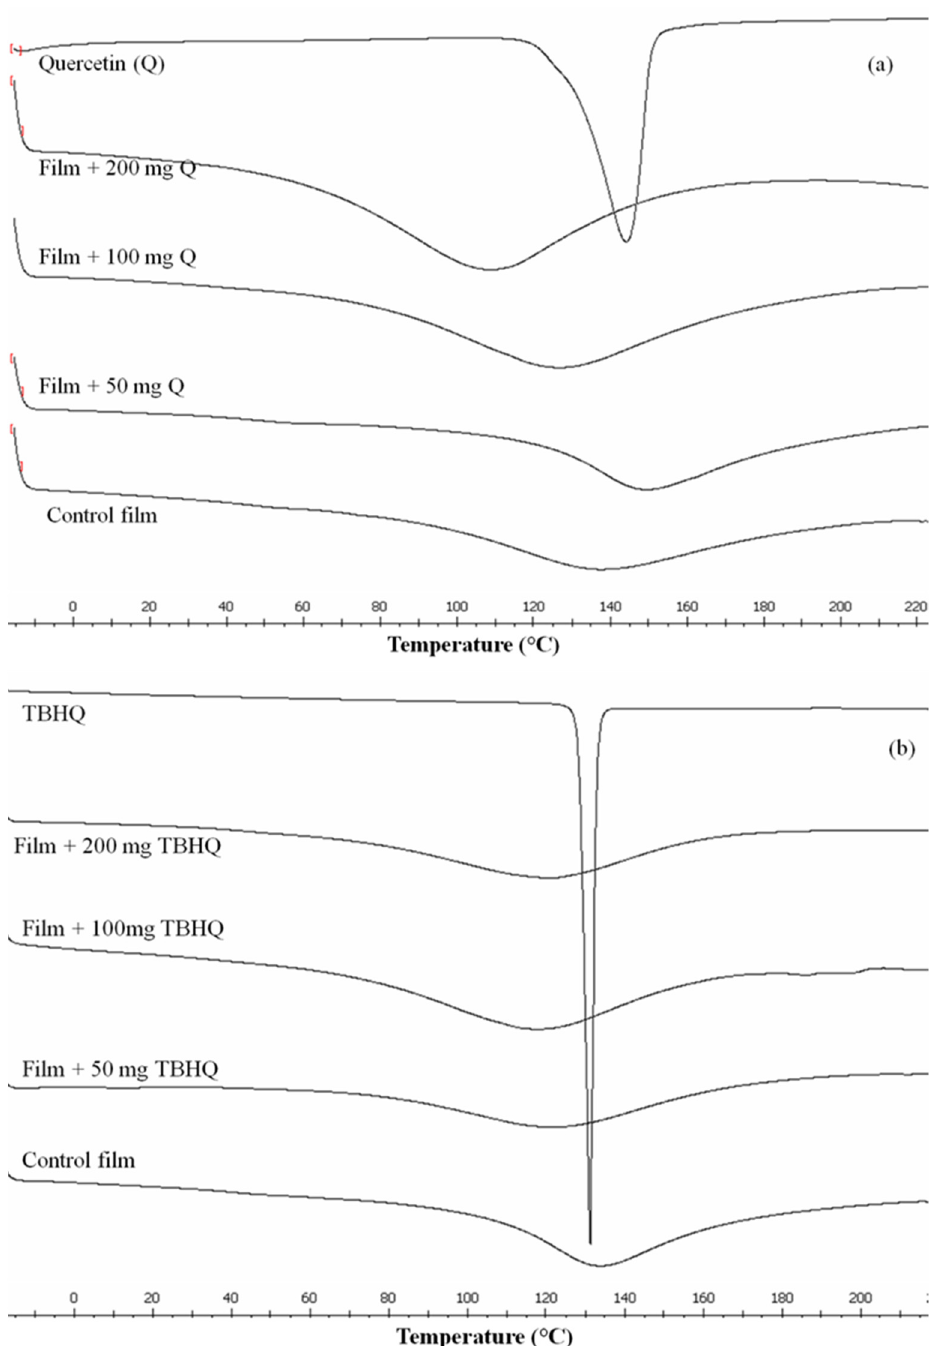
Figure 4. Di ff erential Scanning Calorimetry (DSC) thermograms of cassava starch–CMC films with ( a ) Figure 4. Differential Scanning Calorimetry ( DSC) thermograms of cassava starch–CMC films with quercetin and ( b ) ( a ) quercetin and ( b ) TBHQ.